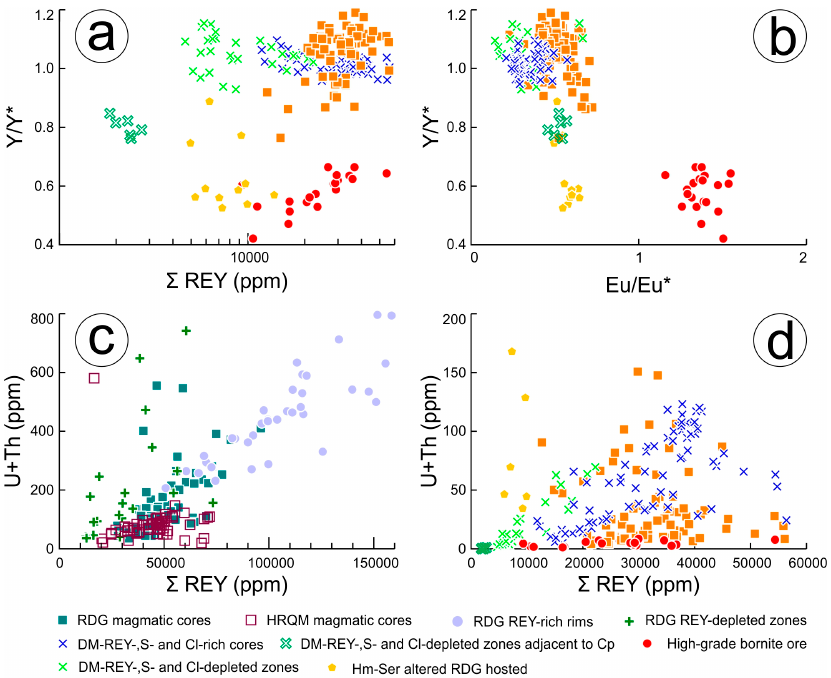
Figure 9. LA-ICP-MS plots of magmatic and hydrothermal apatite: ( a ) Σ REY (ppm) vs. (Y/Y* = Y CN /[(Dy CN + Ho CN )/2]); ( b ) (Eu/Eu* = Eu CN /[(Sm CN + Gd CN )/2]) vs. (Y/Y* = Y CN /[(Dy CN + Ho CN )/2]); ( a , b ) The evolution from early magnetite associated to later hematite-sericite and ore-related apatite is emphasized by changes is Σ REY as well as Eu and Y anomalies; ( c ) Σ REY (ppm) vs. (U + Th) (ppm); ( d ) Σ REY (ppm) vs. (U + Th) (ppm). ( c , d ) U and Th concentrations are strongly tied to that of Σ REY,